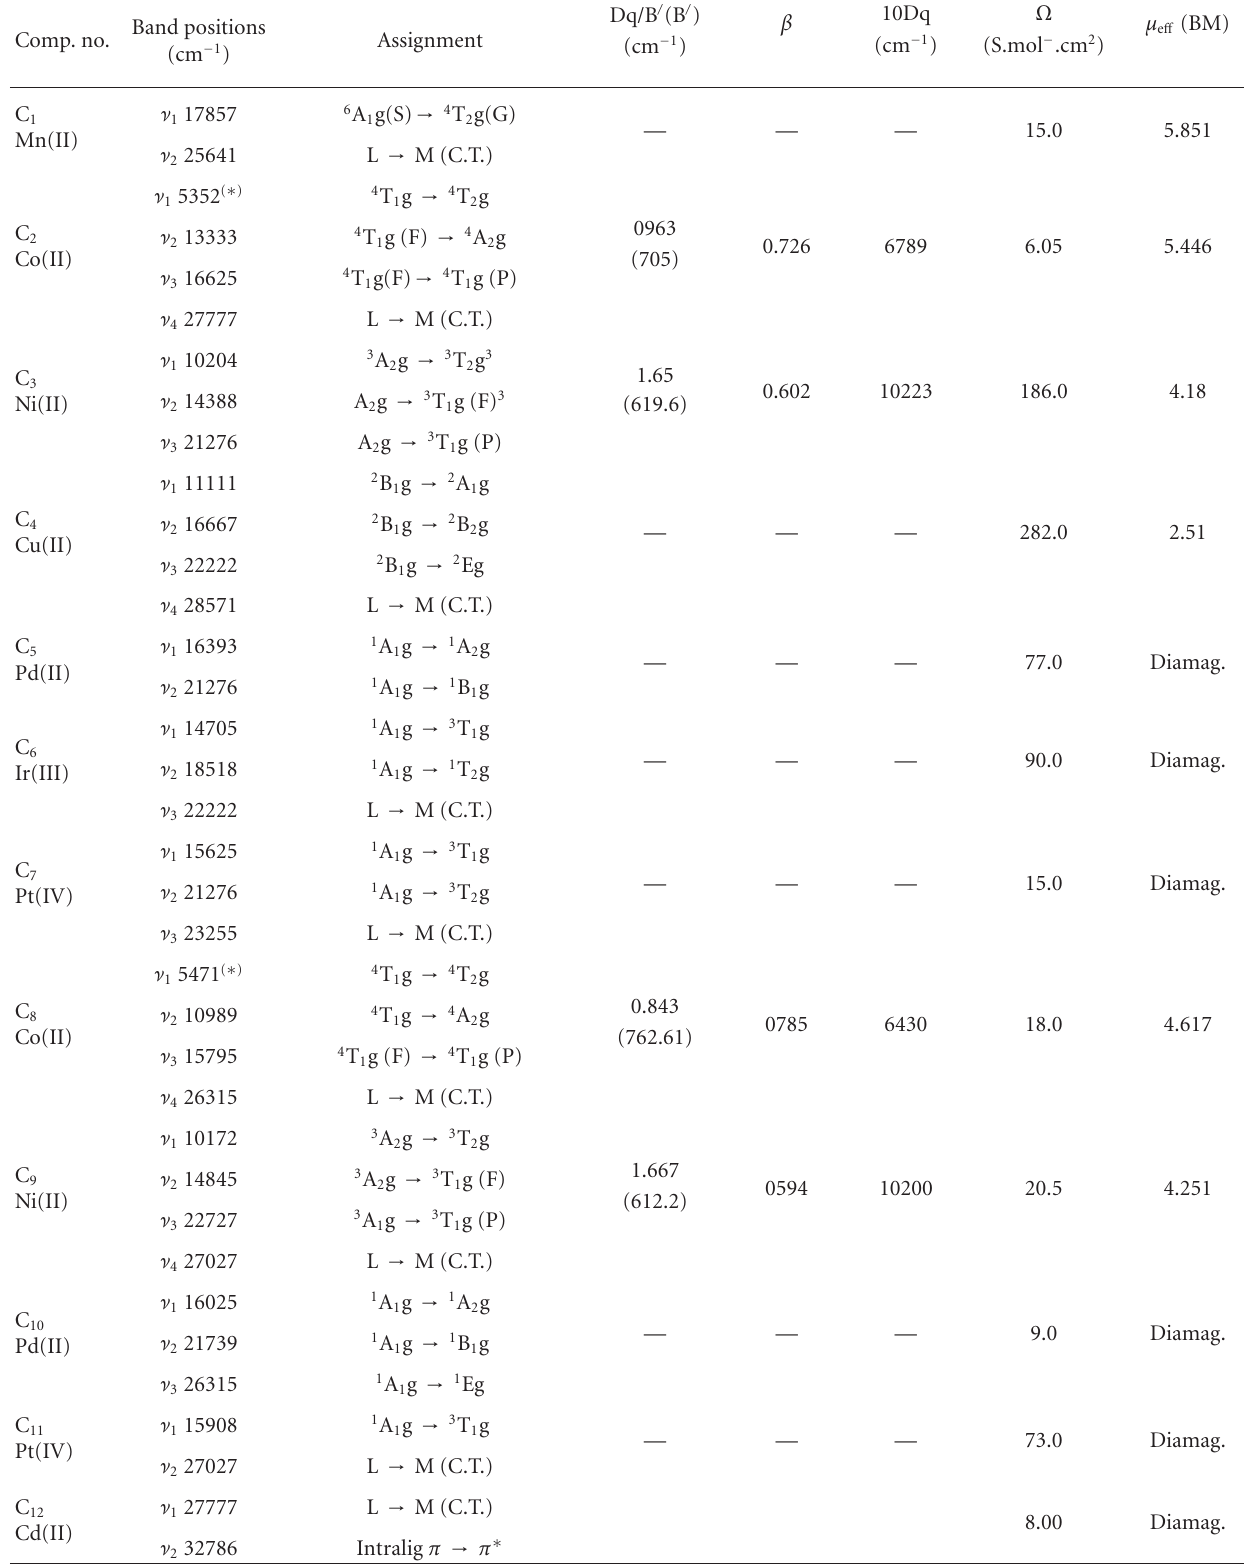
Table 4: Electronic spectra, spectral parameters, molar conductivity, and e ff ective magnetic moments ( μ e ff ) of Schi ff and Mannich base